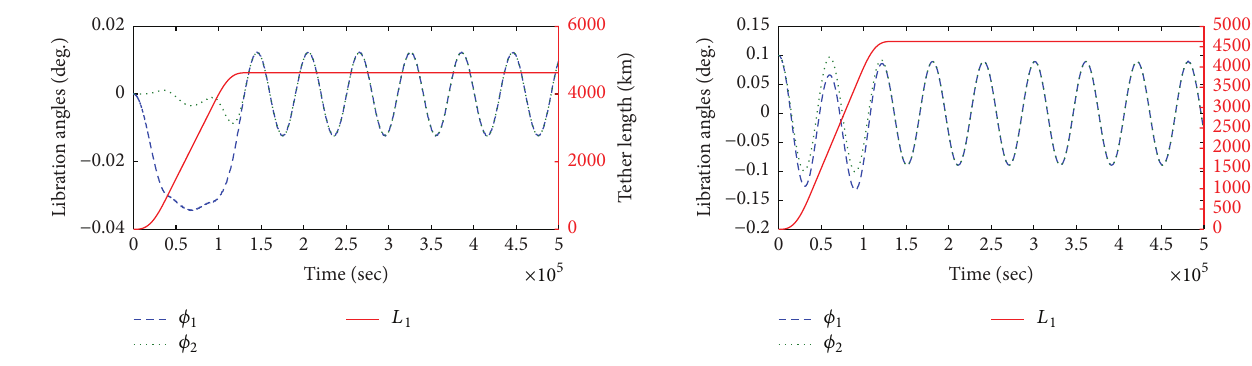
Figure 14: Libration angles 𝜙 1 (𝑡) and 𝜙 2 (𝑡) as functions of time based on the prescribed function 𝐿 1 (𝑡) on a circular orbit.